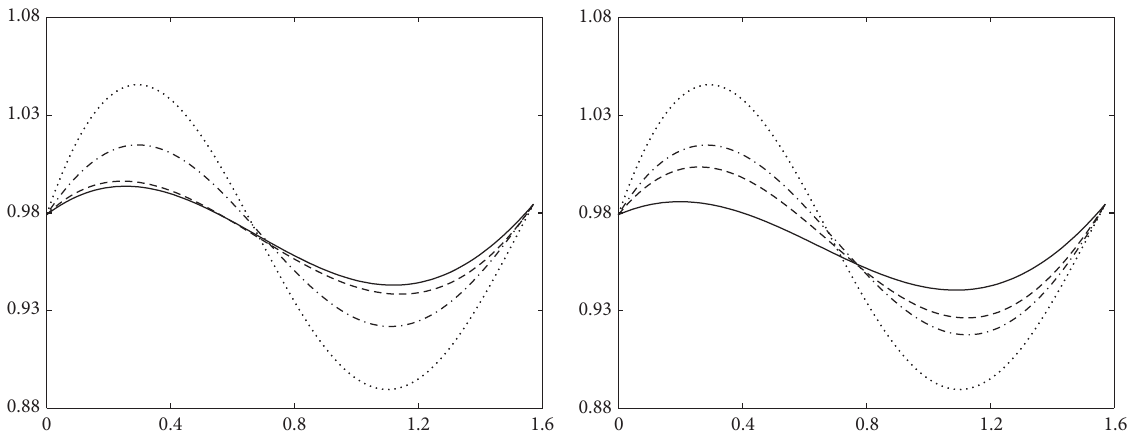
Figure 3: Approximation curves for the function 𝑓 2 .